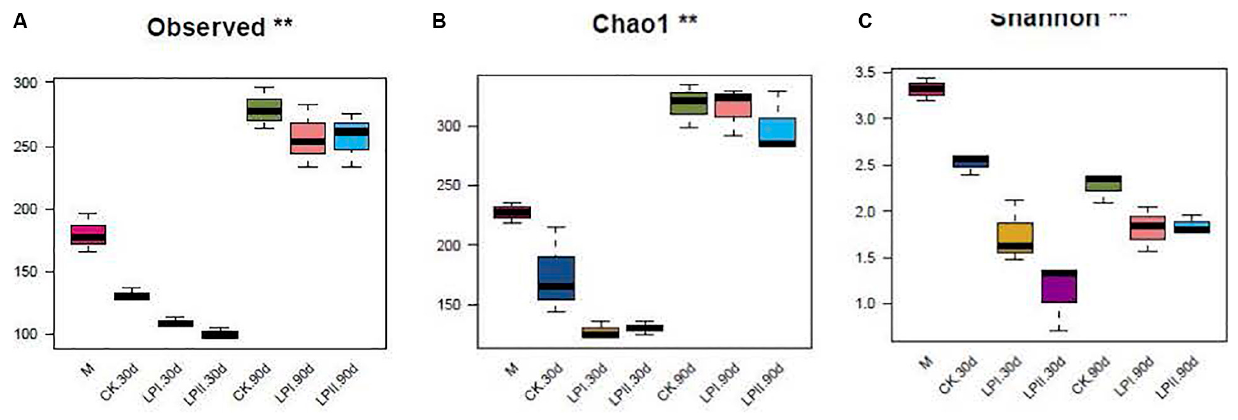
FIGURE 1 | Box-plots of observed bacterial species (A) , Chao 1 (B) and Shannon indices (C) of bacterial communities in alfalfa silage. M, alfalfa material before ensiling; CK, control; LPI, inoculated with L. plantarum YX; LPII, inoculated with L. plantarum A345. The numbers following CK, LPI, and LPII stand for ensiled